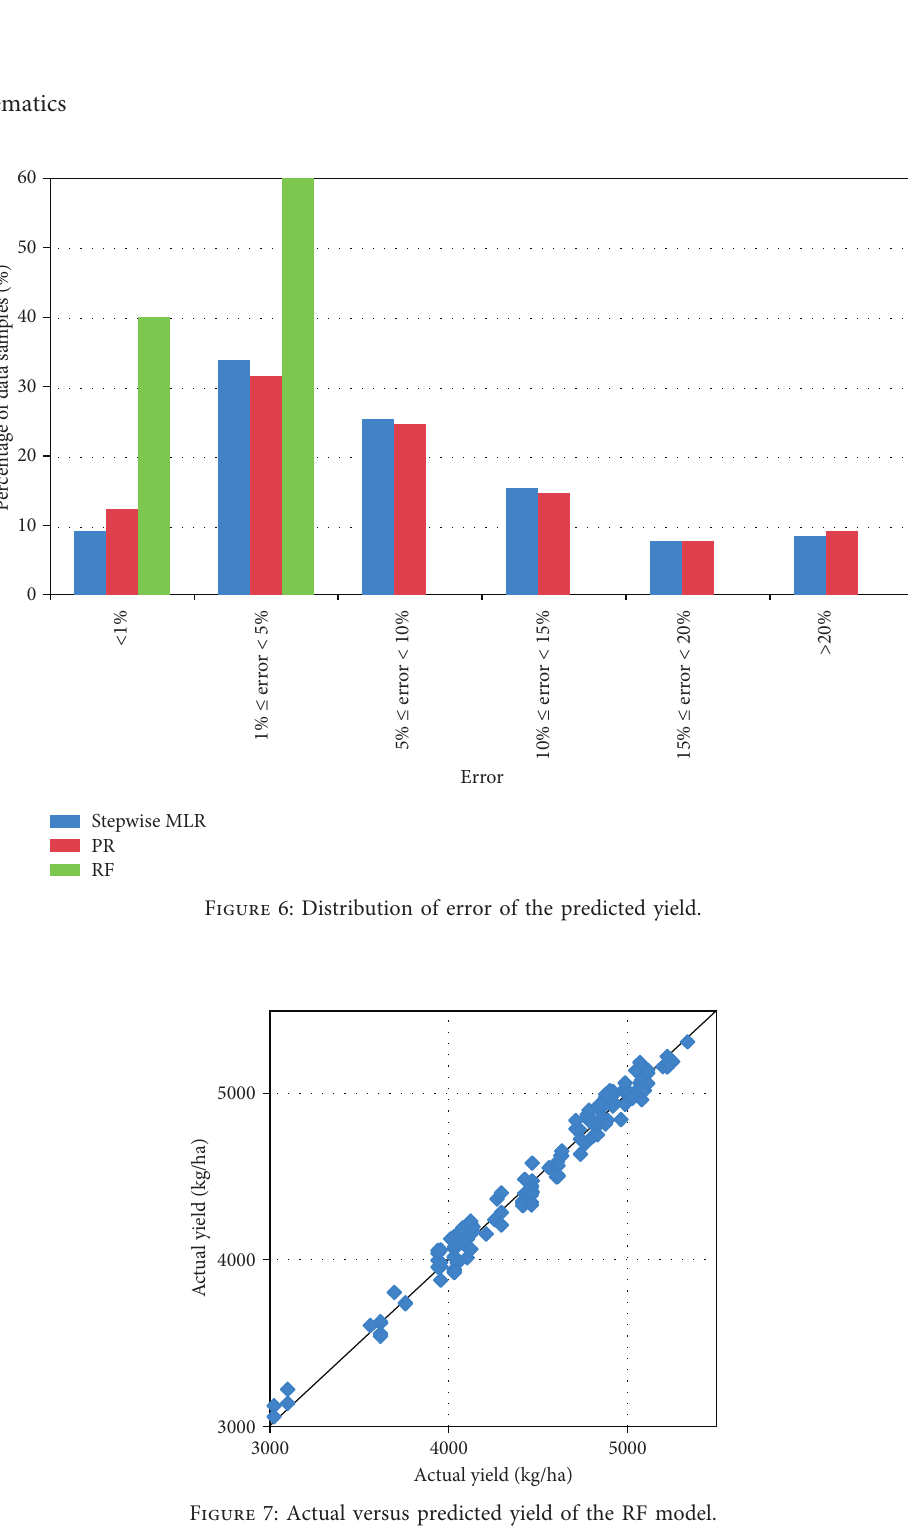
Figure 7: Actual versus predicted yield of the RF